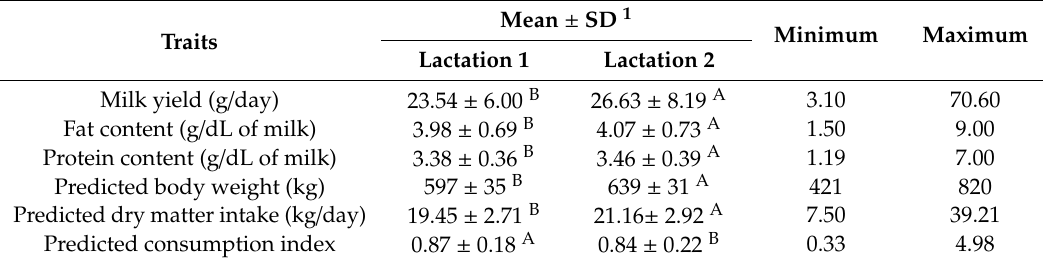
Table 1. Descriptive statistics of the studied datasets.